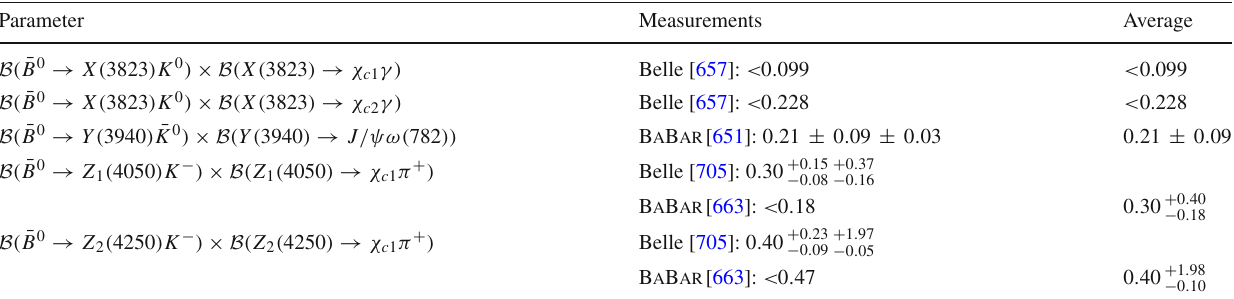
Table 131 Decays to neutral states other than X ( 3872 ) [ 10 − 4 ]